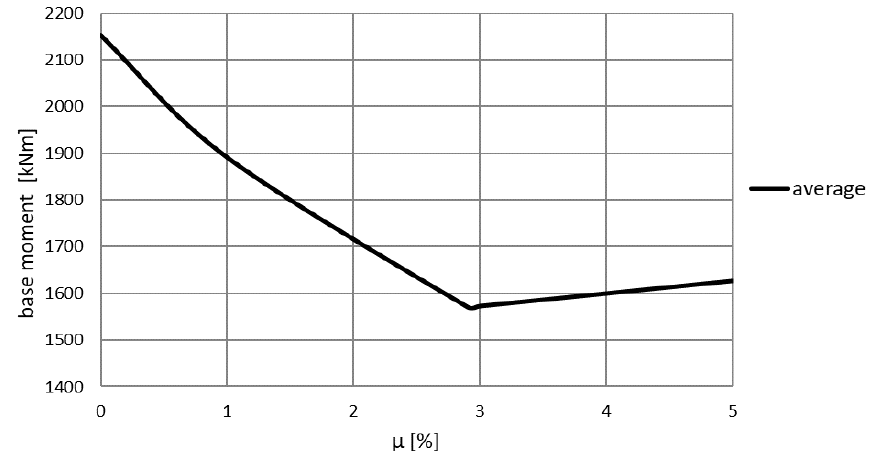
Figure 9. Base moment against the mass ratio, µ considering the TMD positioned at 26.50 m.